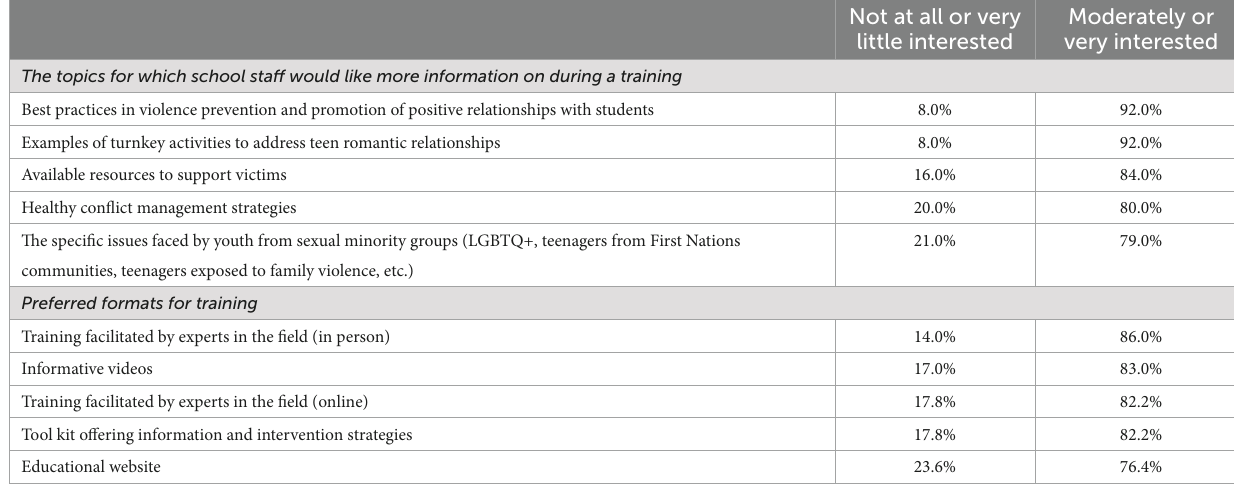
TABLE 3 Top 5 participants’ preferences regarding topics and format for training on positive relationships and DV in